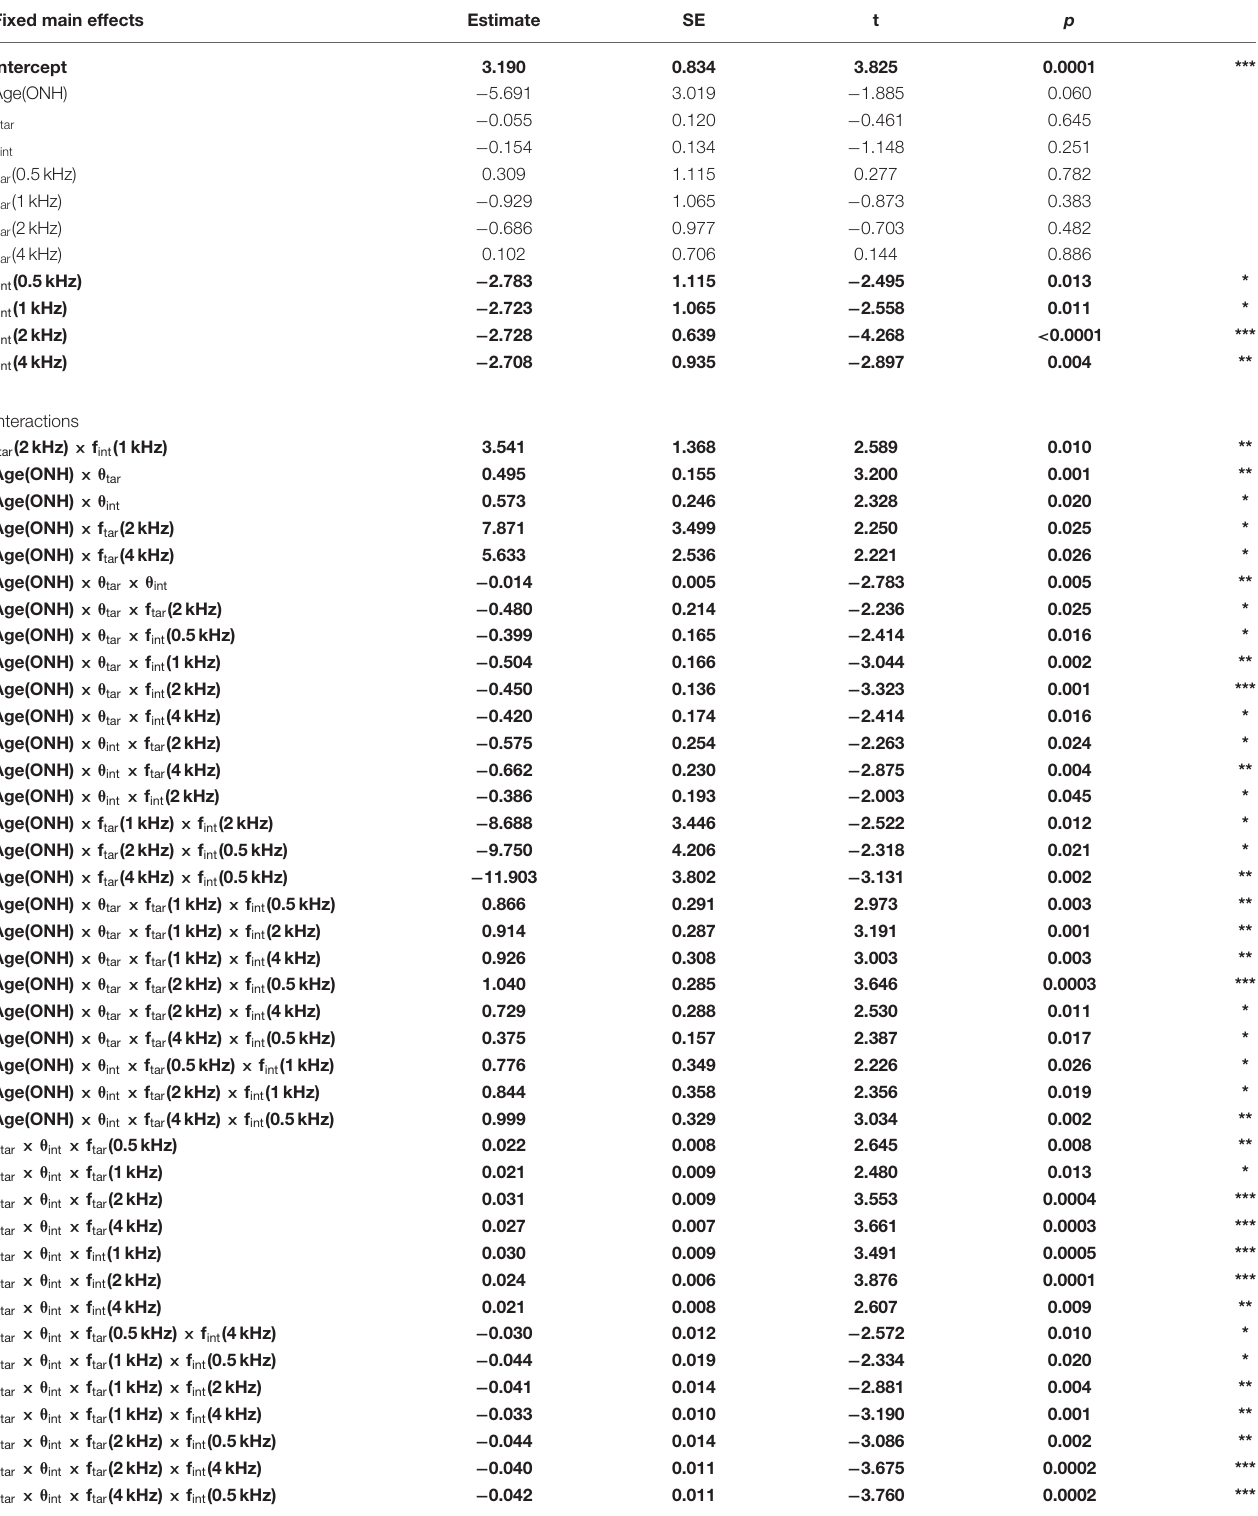
TABLE 2 | Main effects and significant interactions of the multiple regression for the binaural interference index (interactions that were not significant were omitted for clarity). Fixed main